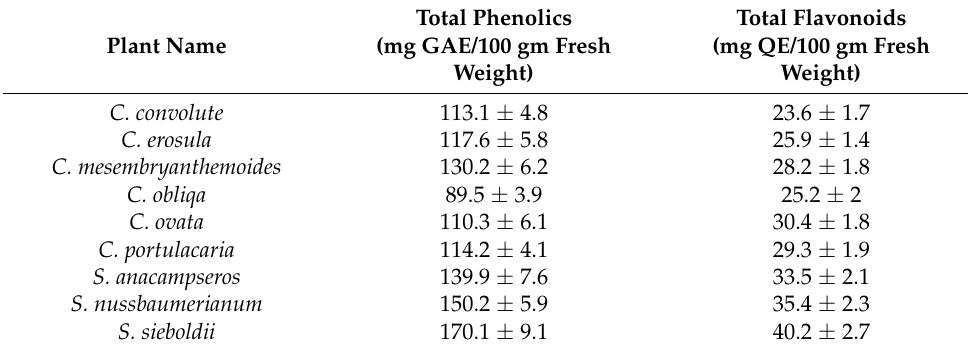
Table 1. Total phenolic and total flavonoid contents of the examined plants.